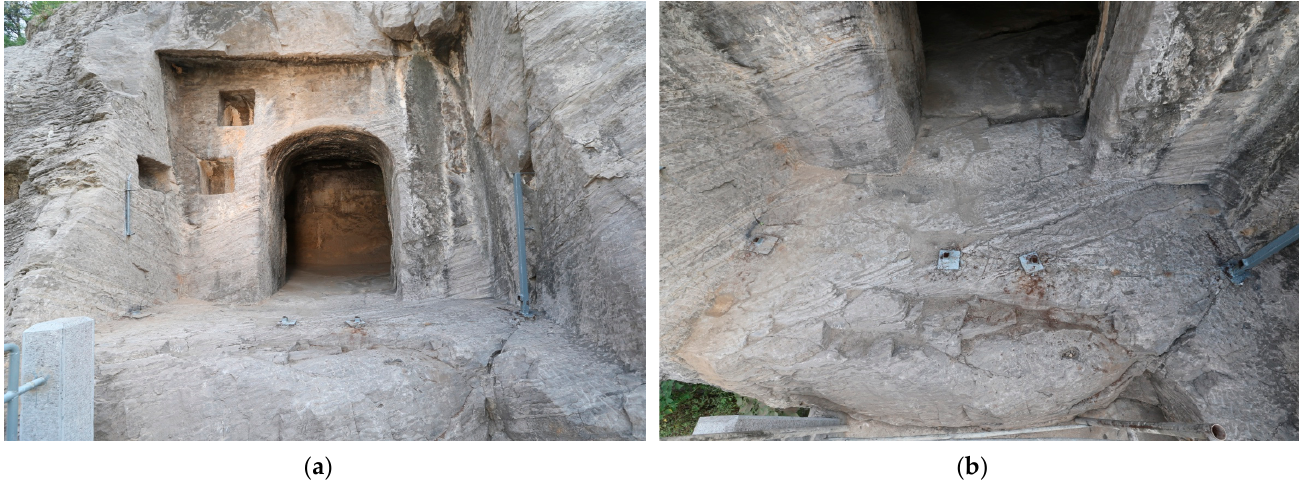
Figure 1. ( a ) Wanfogou Cave 1 (left) with its attached niche (right); ( b ) the restored “stone gate” that had fallen in front of Wanfogou Cave 1. Photos by Li Lan, 2014–2016.